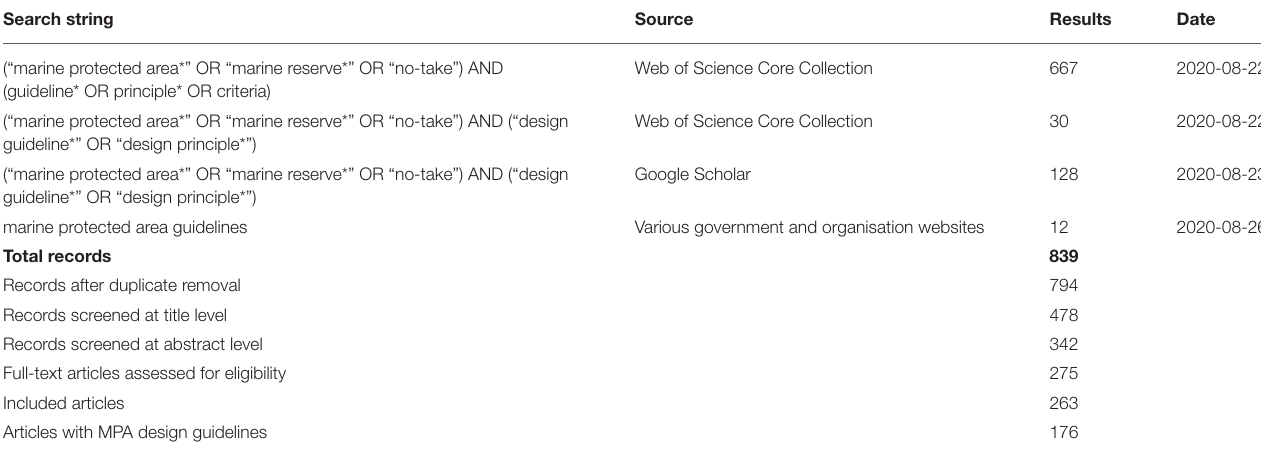
TABLE 1 | Systematic review results of literature search per search string and database (see also Supplementary Information 1 ). Search